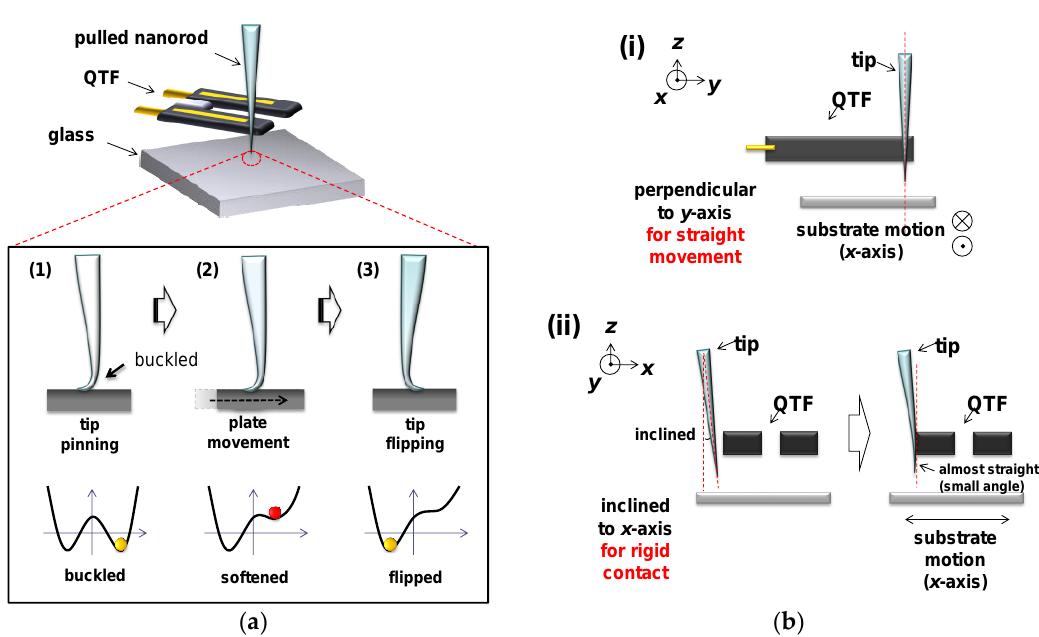
Figure 1. Bucking cantilever-based mechanical sensor: ( a ) experimental procedure is as follows: (1) the sharp cantilever (pulled quartz nanorod) attached on the one prong of the quartz tuning fork (QTF) with apex diameter of ~150 nm, approaches the substrate until contact, gently pushes further to become buckled under flexural stress. (2) The plate moves laterally and the tip experiences softening with a noise increment at the bifurcation region, which states make a non-linear sensitive mechanical sensor. (3) Finally, the abrupt flipping of the tip triggered by its lateral movement or an external impact of mechanical disturbance; ( b ) the tip installed perpendicular to y -axis for straight movement and inclined to x -axis for rigid contact.